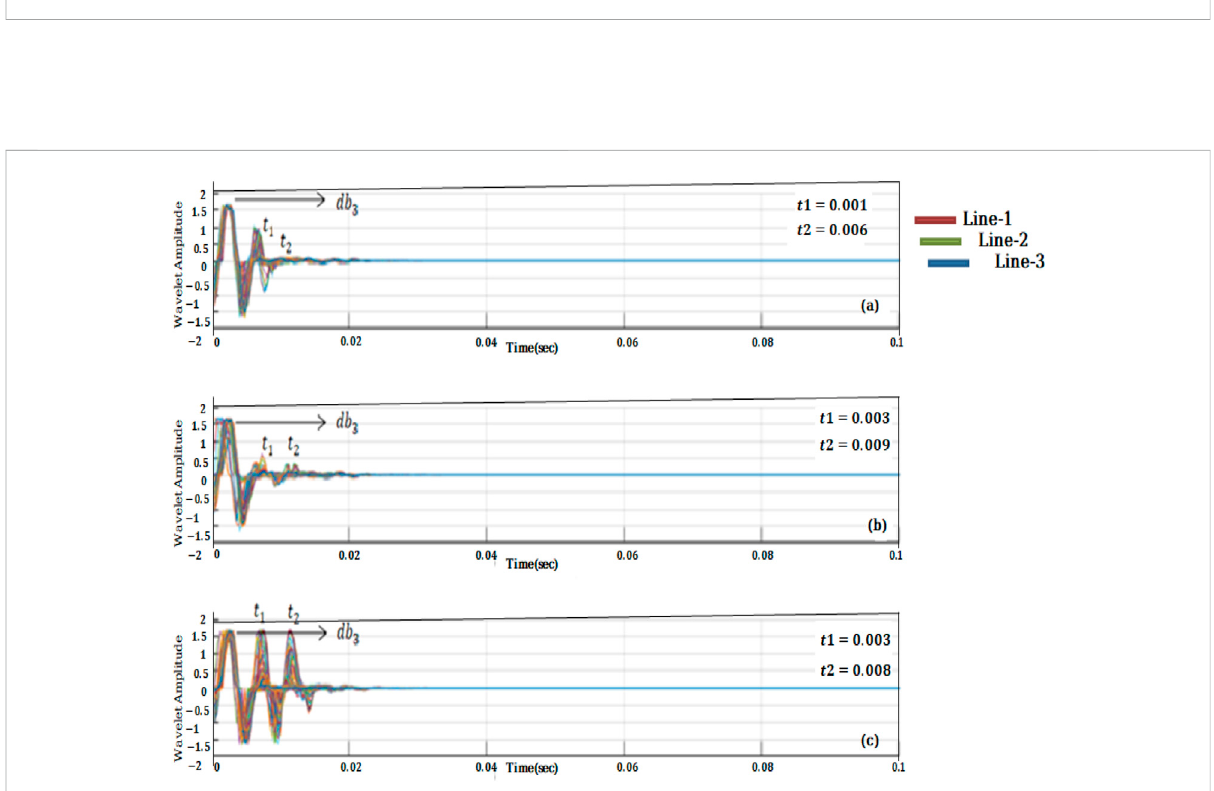
FIGURE 10 For (A) a typical single-channel signal on the survey line 1: db3 wavelet basis, the wavelet transforms coef fi cient module curves obtained by using different wavelet bases. (B) Wavelet basis of a typical single-channel signal on survey line 2: db3. (C) db 3 wavelet basis for a typical single- channel signal on survey line